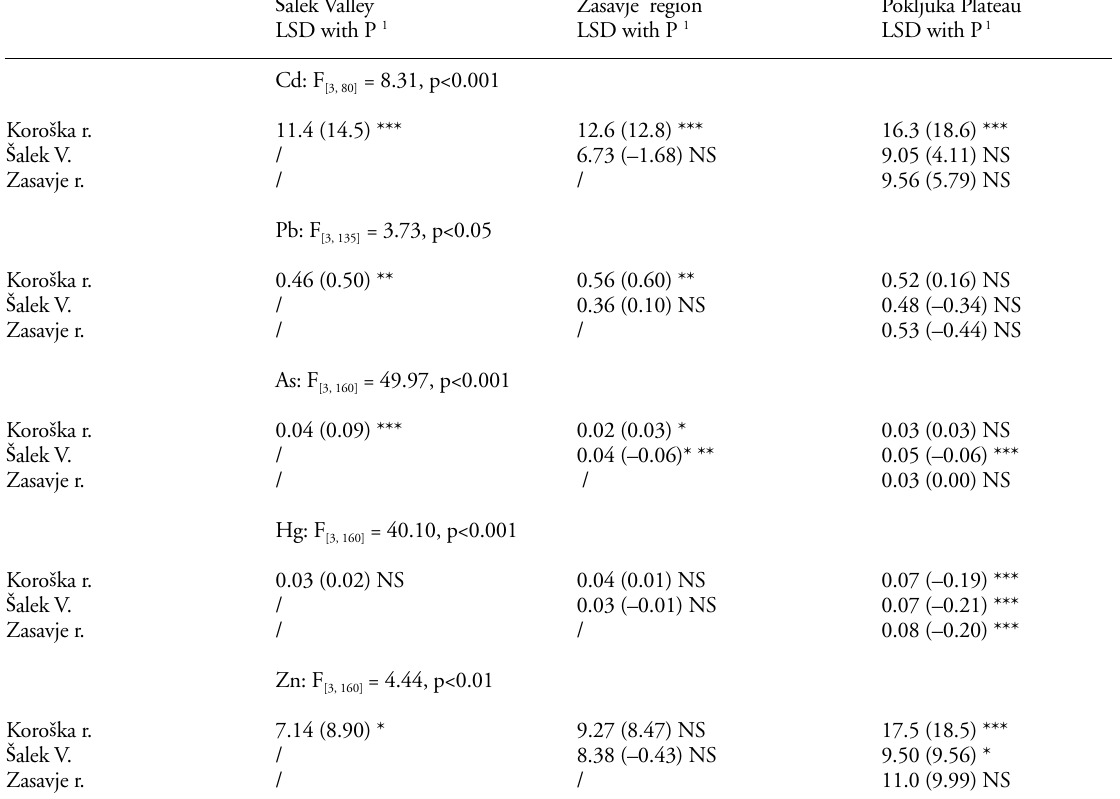
Table 6. Statistical comparison among areas (ANOVA; differences between two areas were determined by calculation of LSD, which are presented herein; the actual differences in arithmetic means for selected element between two areas are given in parenthesis; for n see Tables